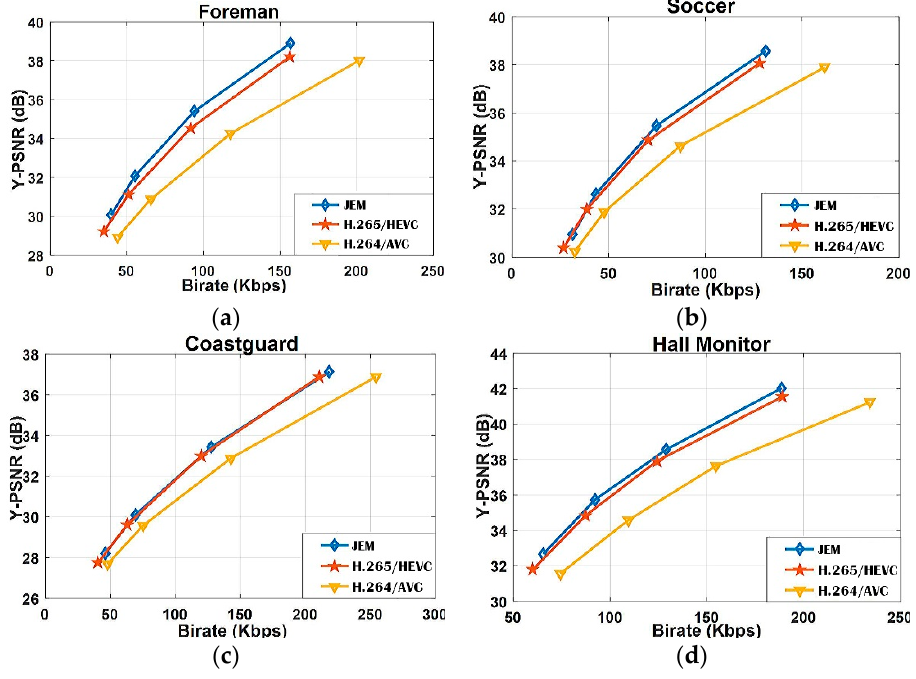
Figure 7. Key frame coding evaluation with different codecs: H.265-DVC, DISCOVER DVC, and the proposed JEM-DVC performed on different test sequences: ( a ) Foreman , ( b ) Soccer , ( c ) Coastguard , and ( d ) Hall Monitor .